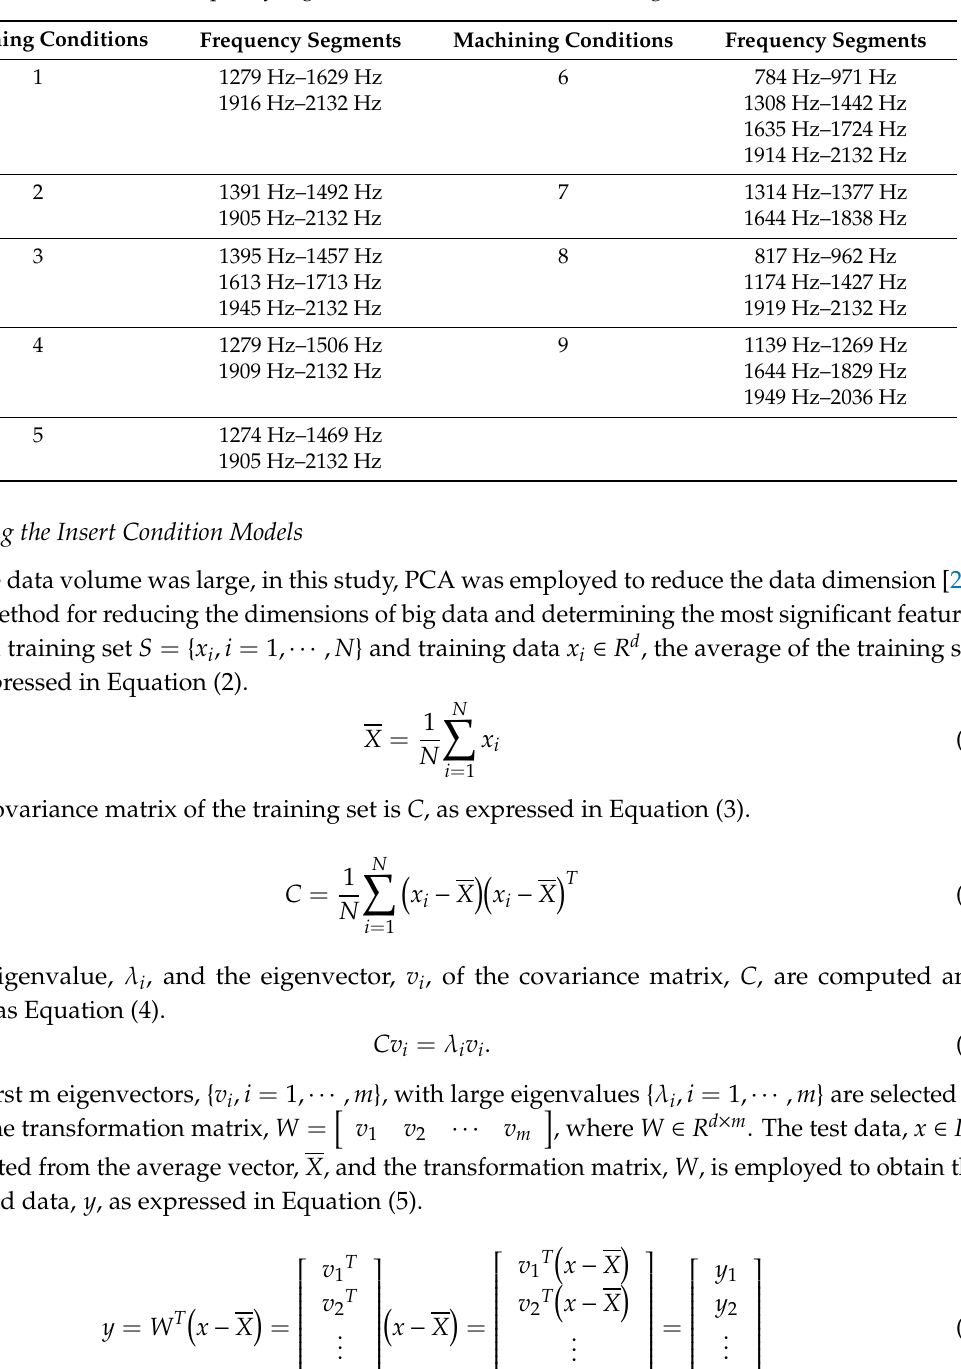
Table 3. Frequency segment results of di ff erent machining